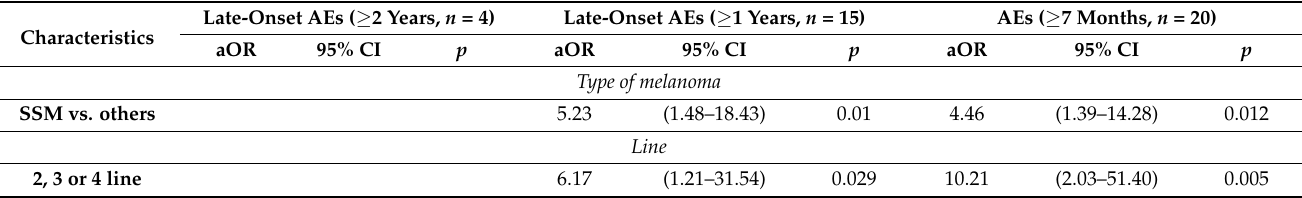
Table 5. Factors associated with late-onset events (7 months, 1 year, 2 years) by multivariate analyscheme 95. ( CI = l: 95% confidence interval; p: p-value for multivariate logistic regression